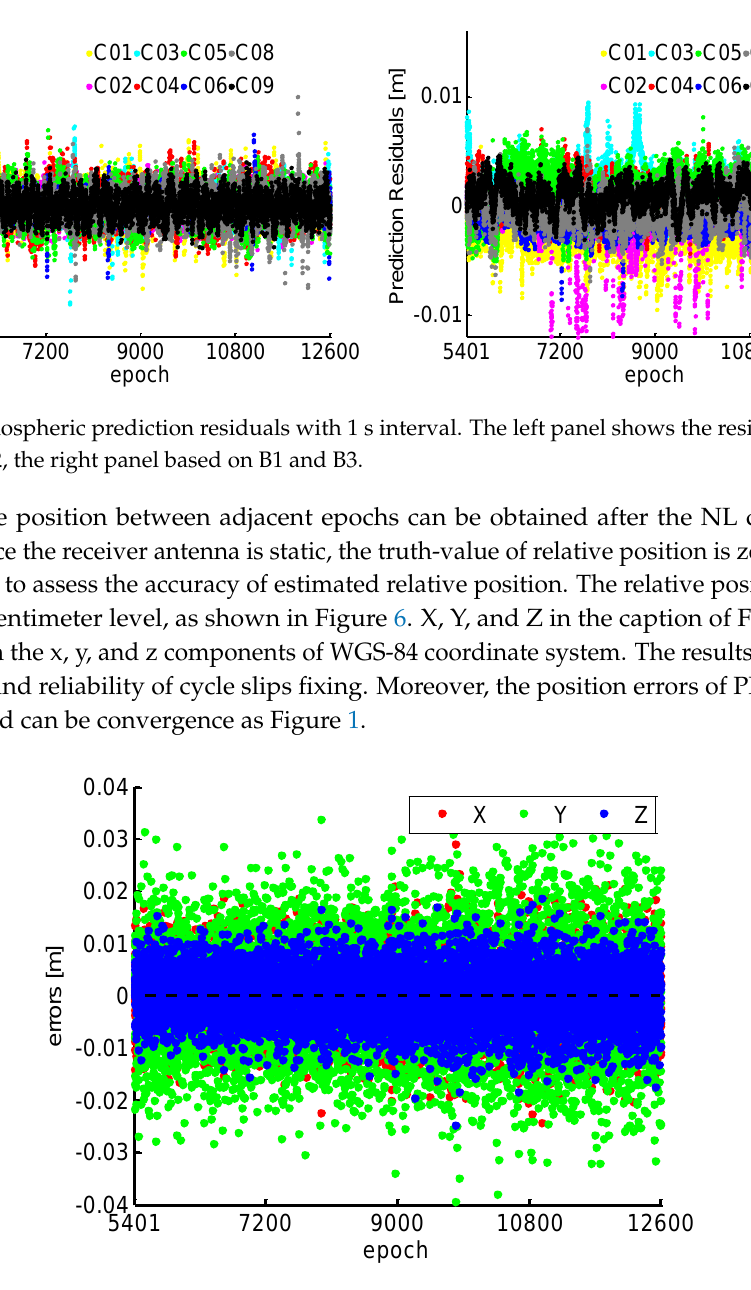
Figure 4. Relative ionospheric delay variation values.